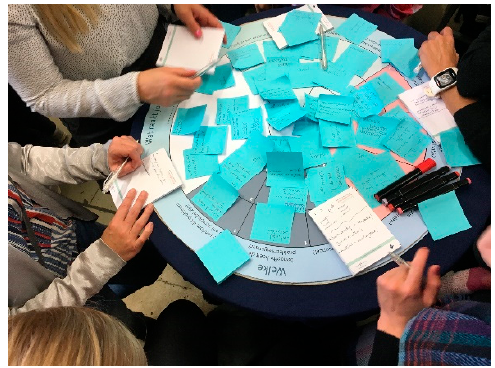
Figure 2. National inspiration day 2019.